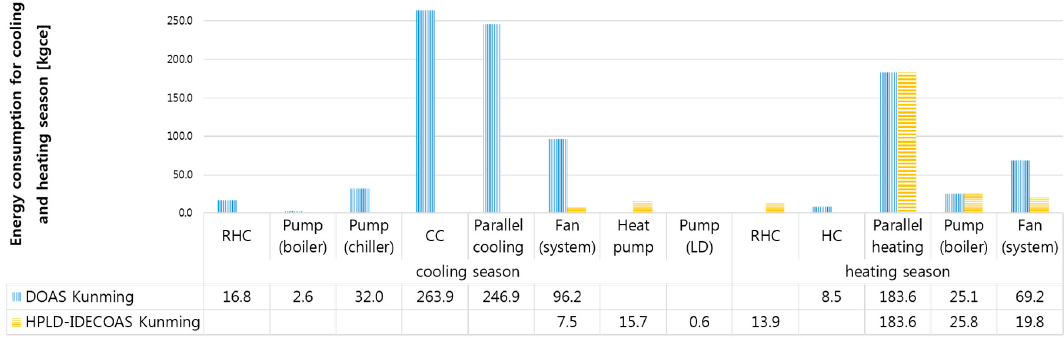
Figure 22. Comparison of seasonal energy consumption in Kunming.